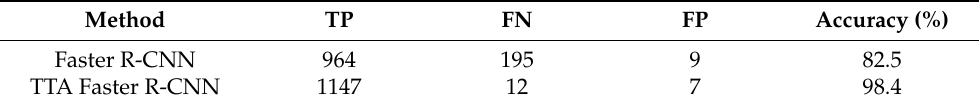
Figure 8. The full field of view image of the HT901 with dendrite core is recognized by TTA Faster R-CNN. The red star in the figure represents the dendrite core recognized by the detection model, the blue circle represents the result of false detection, and the green circle represents the dendrite core not detected by the detection model. Table 2. The extraction results of dendrite cores by Faster R-CNN and TTA Faster R-CNN.